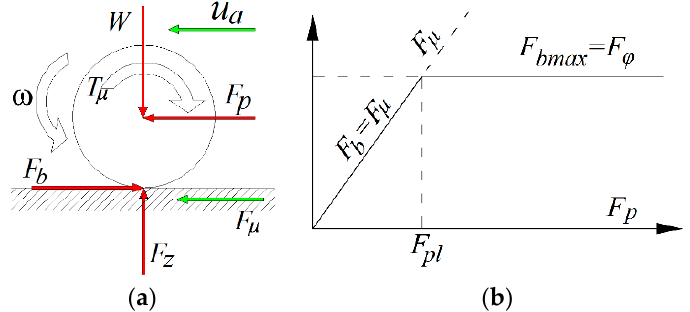
Figure 1. Principles of braking force. ( a ) Principles of braking force; ( b ) Relationship of F µ , F b and F φ during braking.